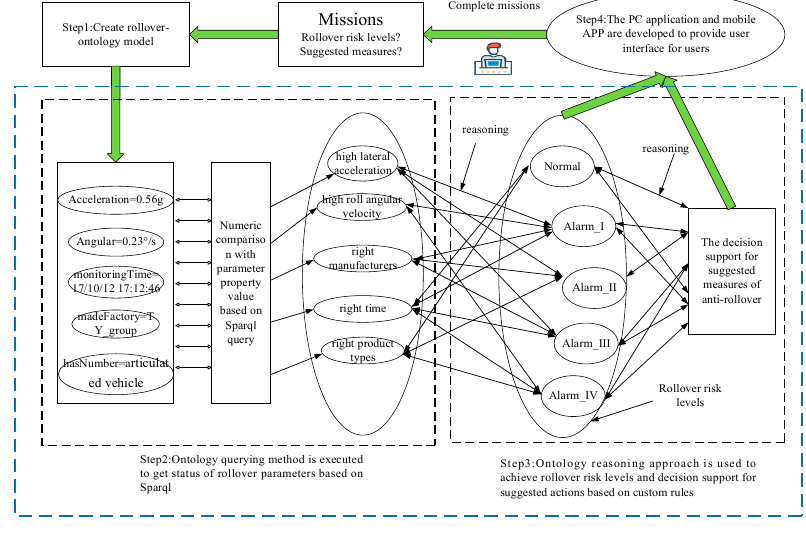
Figure 5. Technical route of ontology querying and reasoning.